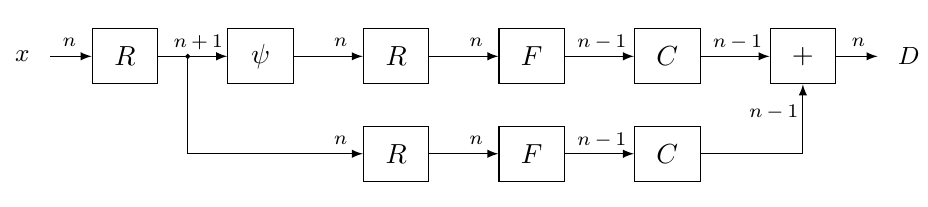
Figure 2: The sequence of gadgets in the Boolean to arithmetic conversion algorithm from